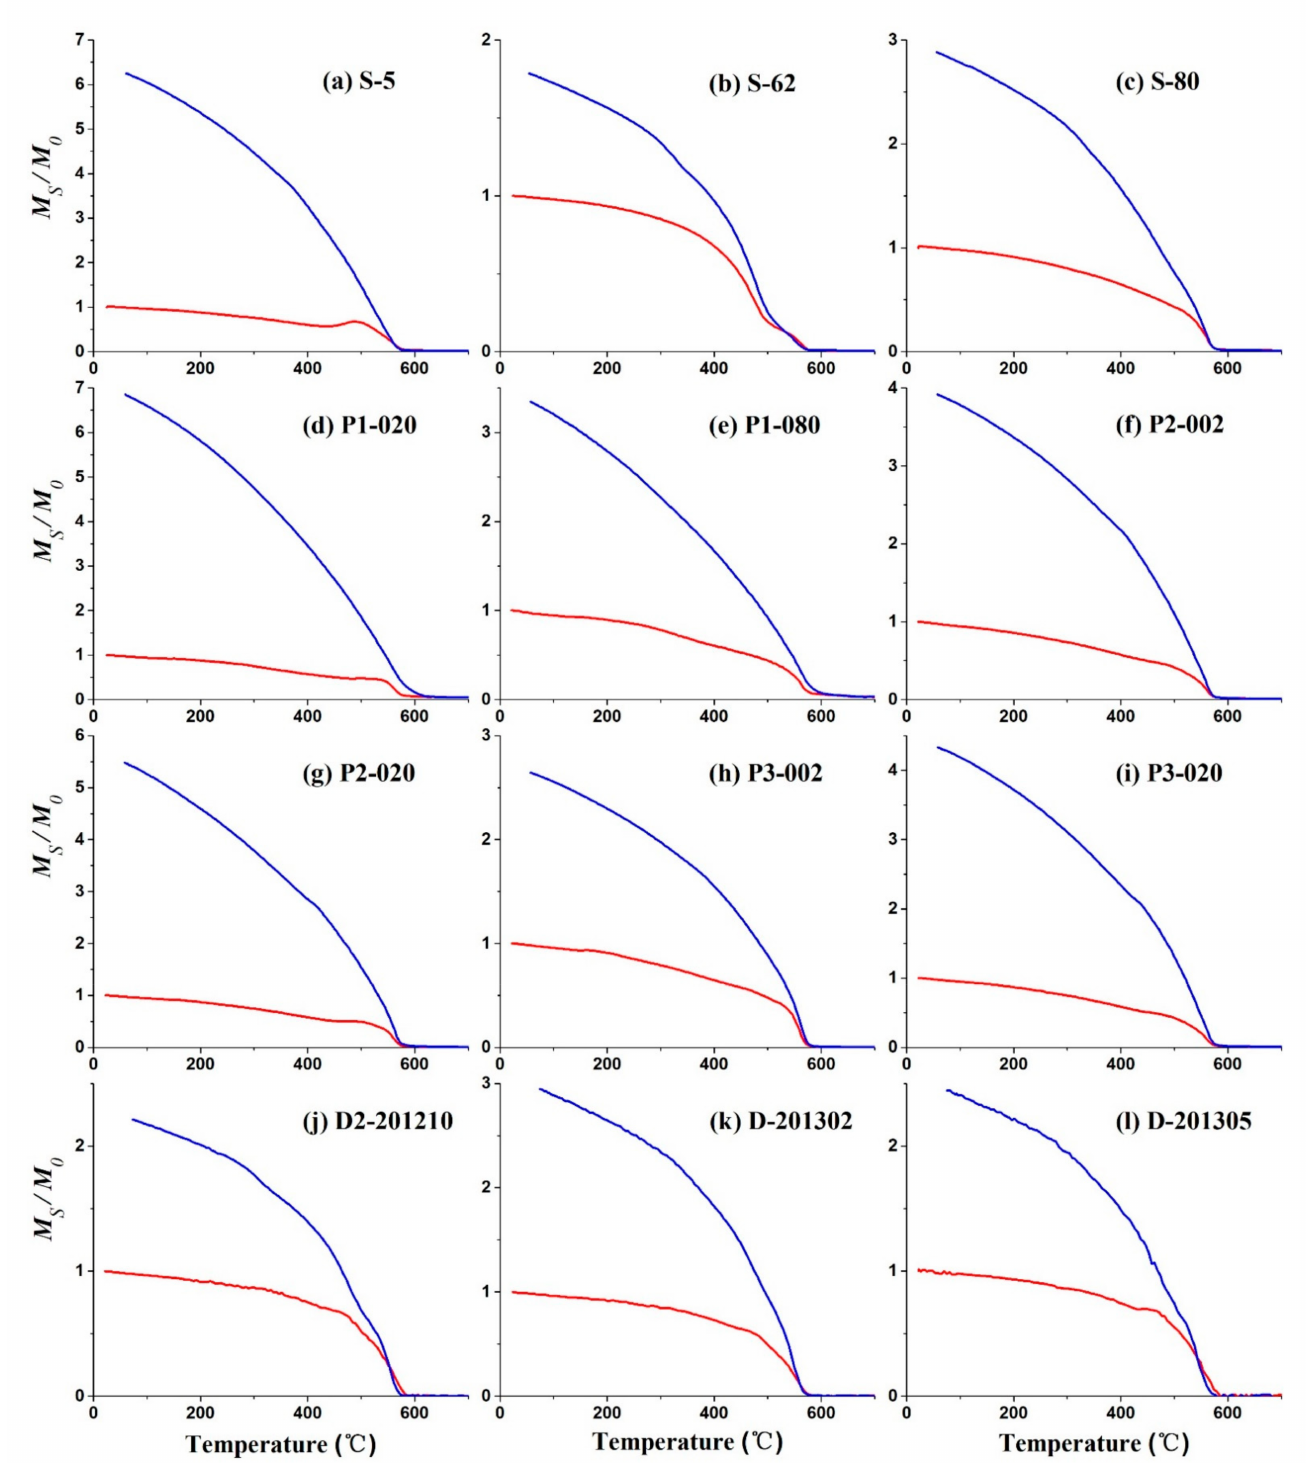
Figure 5. Thermomagnetic curves of typical soil samples. The red line is the heating curve, blue line is the cooling